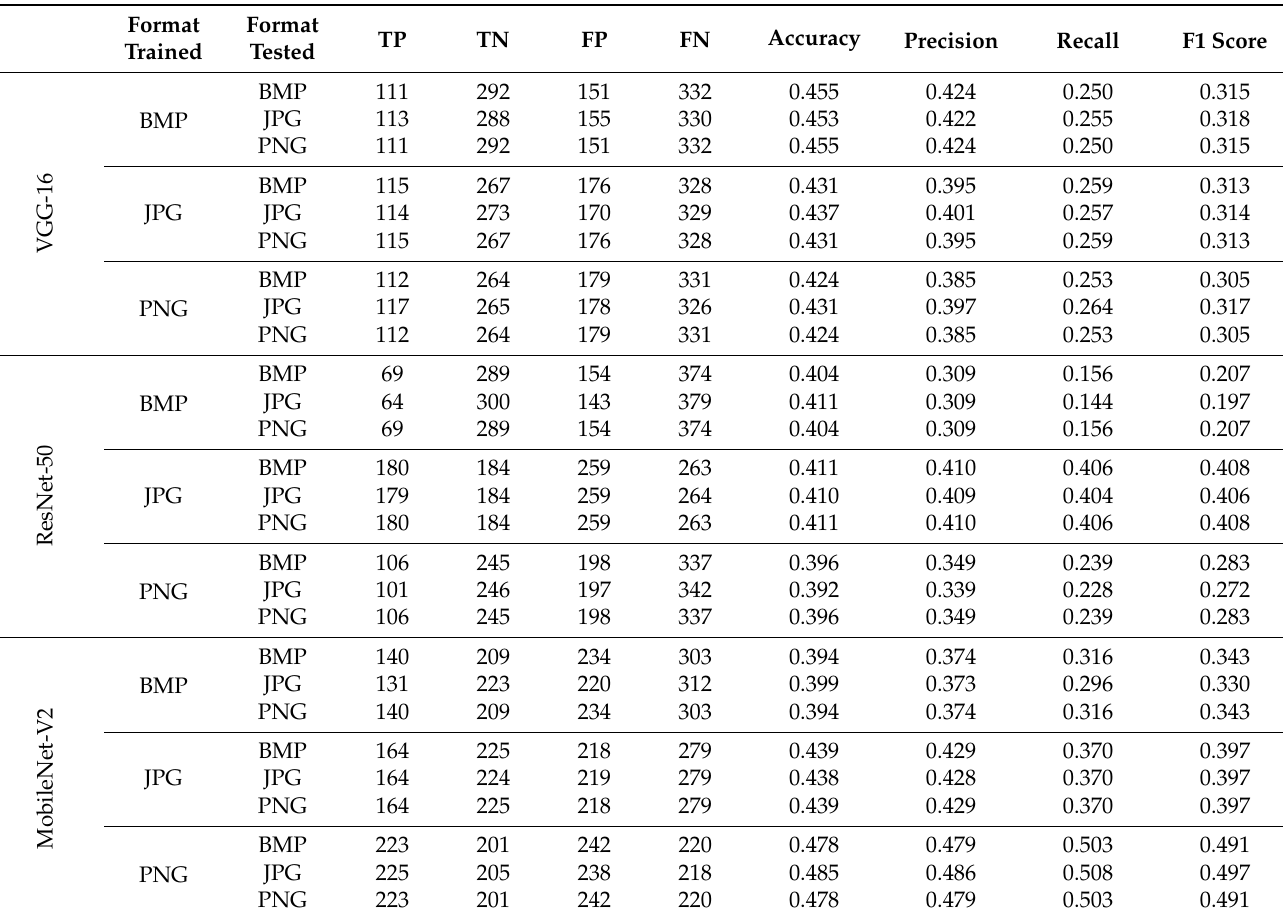
Table 6. Experimental results of large dataset trained 2000 epochs models when evaluated by common file